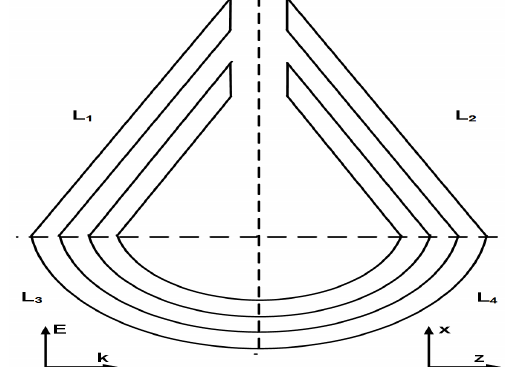
Figure 2: SSHSS divisions for calculation of inductors